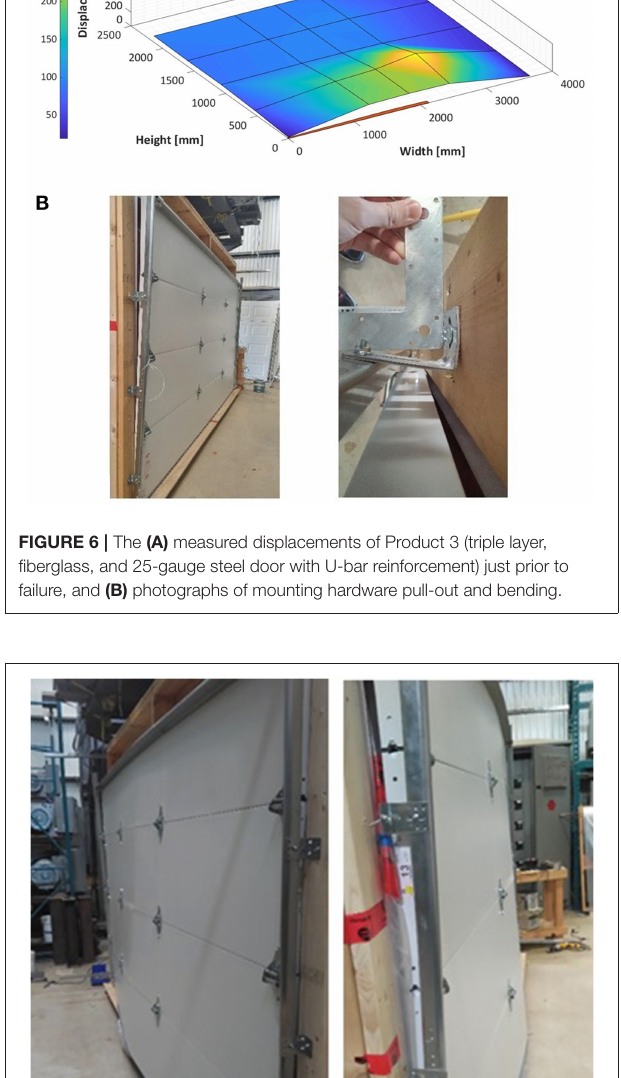
(MDE), both of which are based on the unsteady Bernoulli equation together with loss coefficients to account for friction and other losses. For the SDE, after performing numerical differentiation, rearranging the equation, and substituting in the known parameters, the unknown variables become the internal pressure, p i , and, for the case of flexible garage doors, the